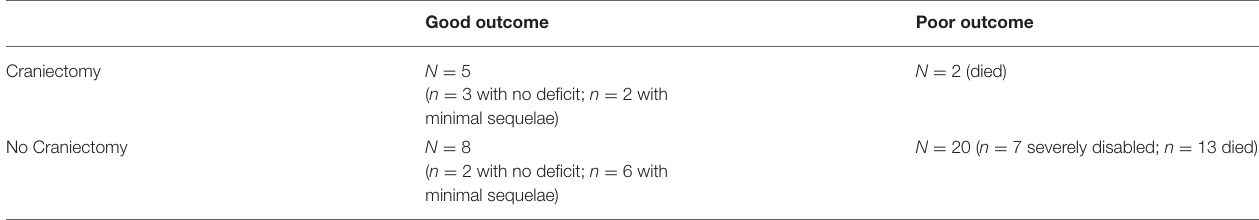
TABLE 3 | Statistical analysis of the outcome of adult AHLE patients regarding craniectomy, Fisher’s exact test, p -value = 0.0754. Good outcome Poor outcome Craniectomy N = 5 ( n = 3 with no deficit; n = 2